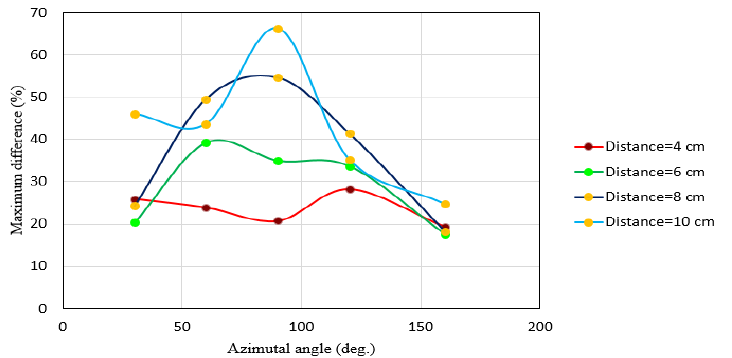
Figure 9. The maximum difference in tangential velocity between vegetated and un-vegetated cases of Figure 8 vs. the azimuthal angle at different distances from the abutment.